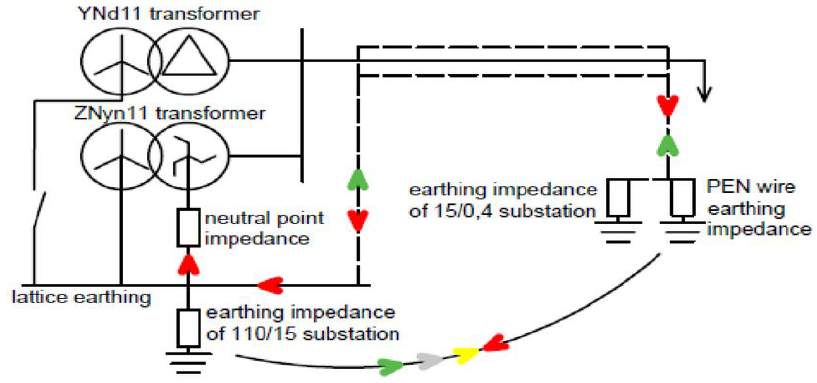
Figure 4. Cable screen current flow.